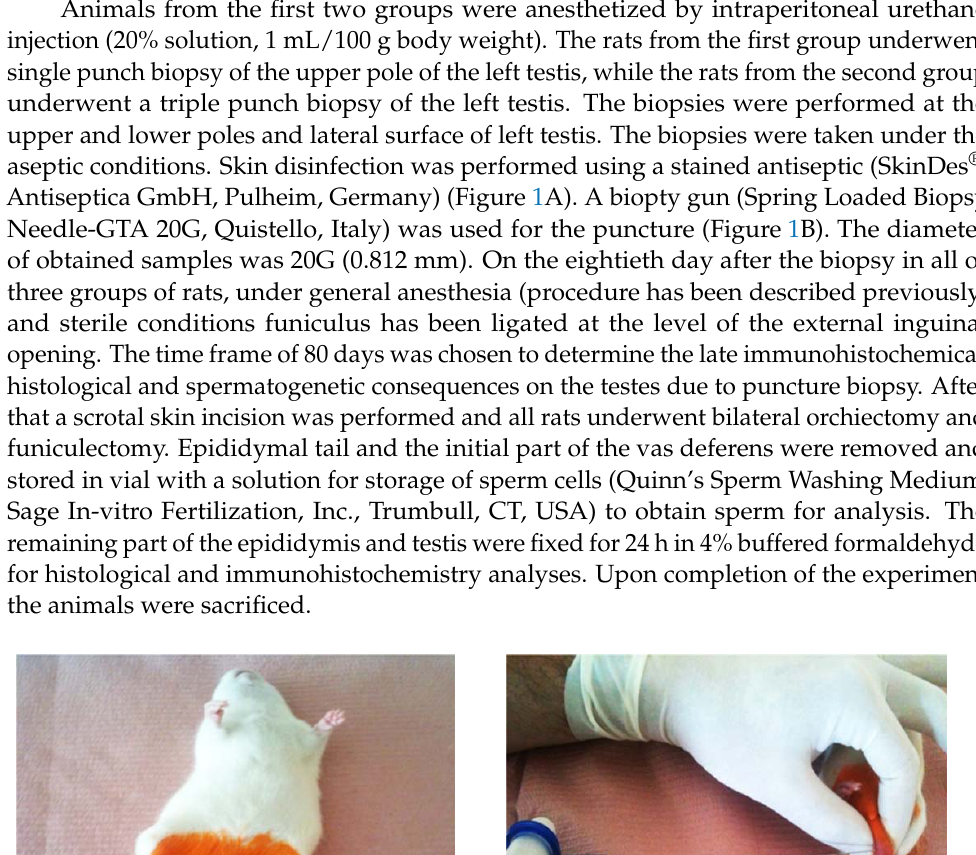
( B ) Figure 2. Histological measurement of tubules: ( A )—normal tubules, HE, magnification ×40; ( B )— atrophic tubules, HE, magnification ×20.